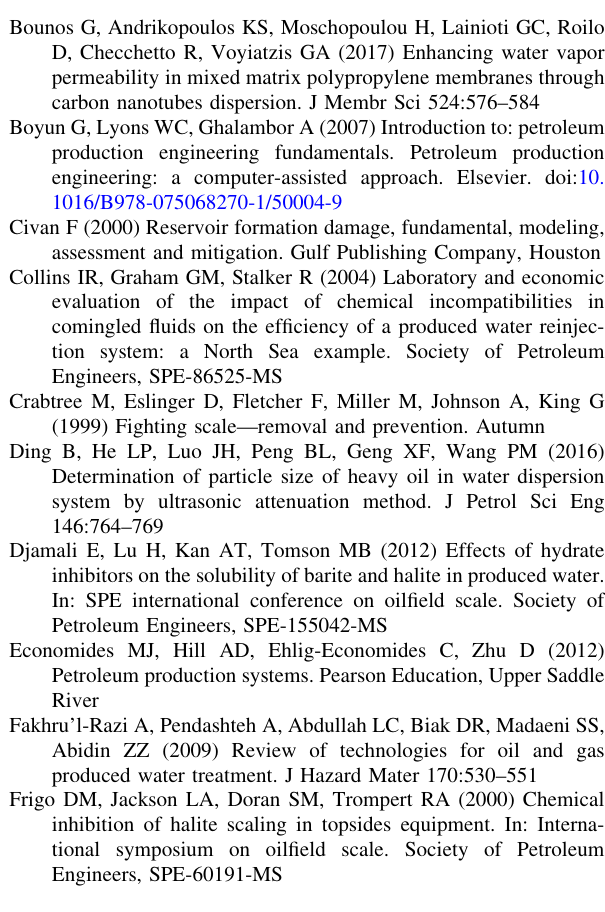
Fig. 12 Effect of water injection and ultrasonic wave radiation on NaCl deposition within the